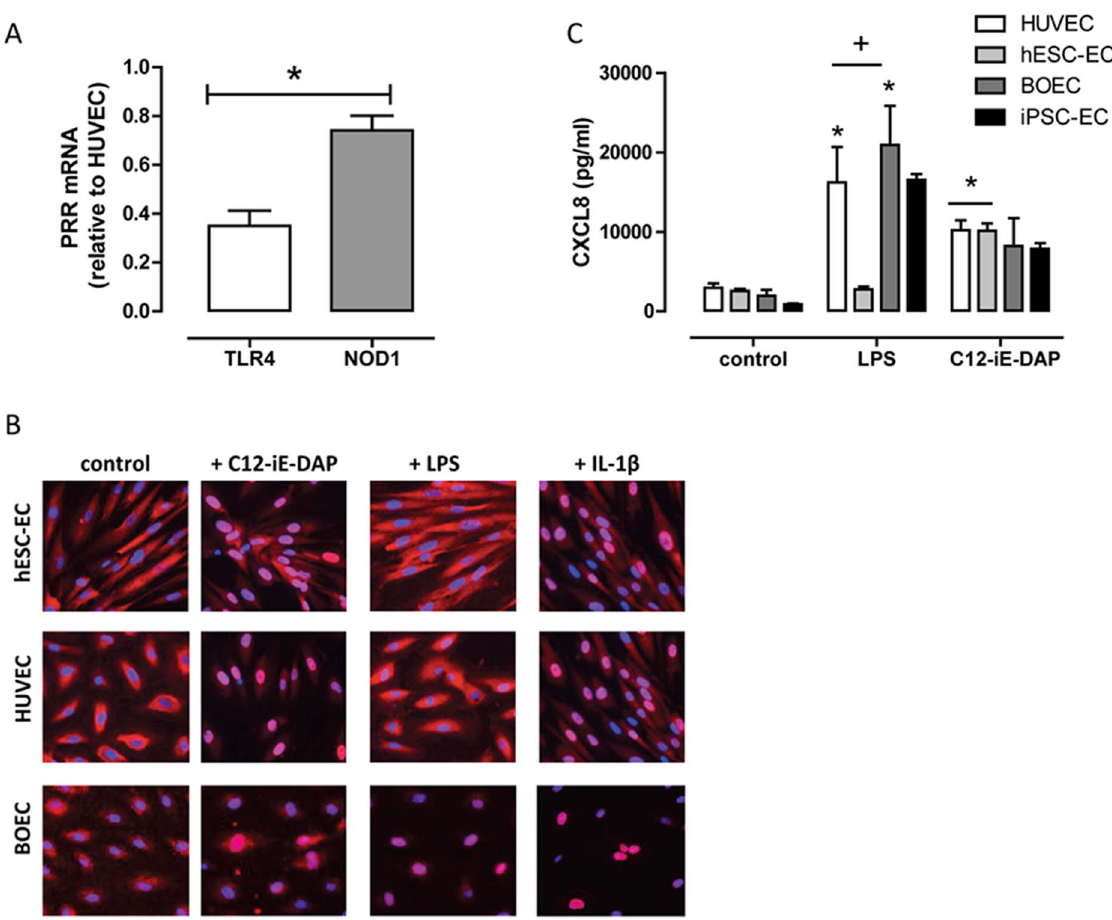
Figure 1. TLR4 and NOD1 expression and function in stem cell derived endothelial cells. (A) TLR4 and NOD1 expression in hESC-EC (relative to expression in HUVEC) in vitro . Data are mean 6 SEM (n=3). Statistical significance was determined by one-sample t-test (*p , 0.05) for NOD1 vs. TLR4 expression. (B) Representative immunocytochemistry images of hESC-EC (top) and HUVEC (bottom) stained for the NF- k B p65-subunit (red) in response to 1 hour treatment with or without, C12-iE-DAP (NOD1 agonist; 10 m g/ml), LPS (TLR4 agonist; 1 m g/ml) or IL-1 b (1 ng/ml). Nuclei were stained with DAPI (blue; 5 m g/ml). Images were acquired using a Cellomics VTi HCS Arrayscanner with a CarlZeiss microscope. (C) LPS (TLR4 agonist; 1 m g/ml) and C12-iE-DAP (NOD1 agonist; 10 m g/ml) induced CXCL8 release after 24 hour stimulation. Data are mean 6 SEM. For HUVEC, hESC-EC or BOEC, n=4–8. For iPSC-EC, n=2, single isolation. Statistical significance was determined by one-way ANOVA followed by Dunnett’s multiple comparison test for each cell type (*p , 0.05) and by two-way ANOVA followed by Bonferroni’s post-test for between cell types. Analysis was not performed on data from iPSC-EC.